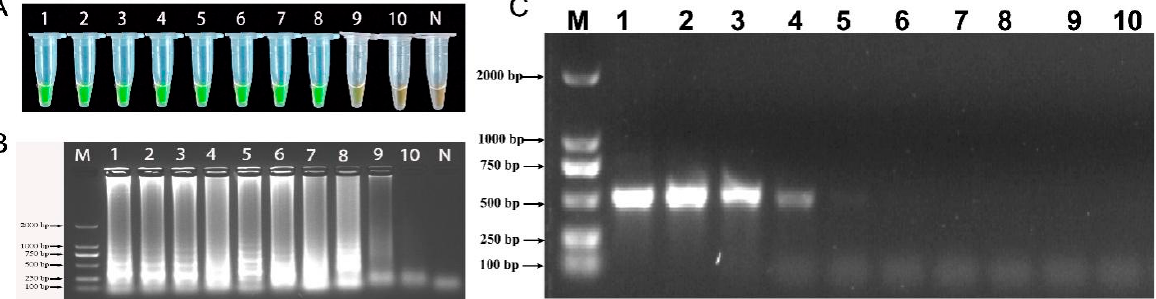
Figure 9. The sensitivity of LAMP and conventional PCR to detect the genomic DNA of A. fabacearum . ( A ) Detection by LAMP with SYBR Green I staining; ( B ) LAMP products analyzed by agarose gel electrophoresis, the LAMP product is aprox. 500 bp; ( C ): conventional PCR analyzed by agarose gel electrophoresis. 1: 50 ng/ μ L, 2: 5 ng/ μ L, 3: 5 × 10 − 1 ng/ μ L, 4: 5 × 10 − 2 ng/ μ L, 5: 5 × 10 − 3 ng/ μ L, 6: 5 × 10 − 4 ng/ μ L, 7: 5 × 10 − 5 ng/ μ L, 8: 5 × 10 − 6 ng/ μ L, 9: 5 × 10 − 7 ng/ μ L, 10: 5 × 10 − 8 ng/ μ L; M: 2000-bp DNA Marker; N: negative control.